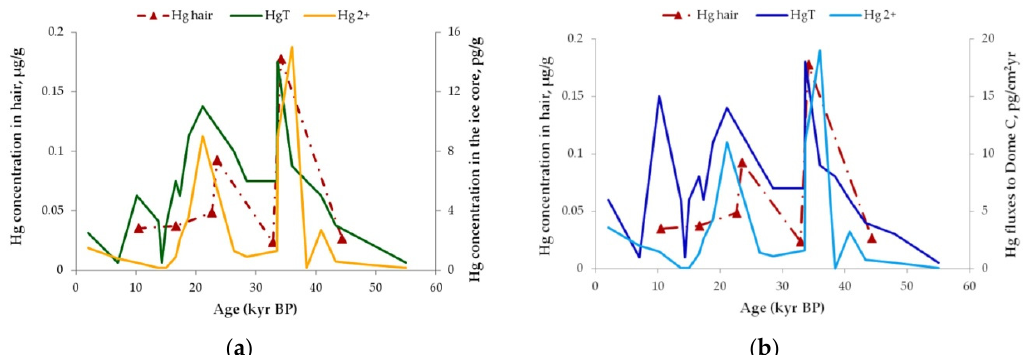
Figure 4. Concentrations ( a ) and fluxes ( b ) of total mercury (HgT) and inorganic mercury (Hg 2+ ) in the EPICA Dome C ice core [67] and total Hg concentrations in mammoth fauna mammals’ hair. Concentrations and fluxes of Hg below the Method Detection Limit (MDL) are presented in the graph as 1/2 of MDL.